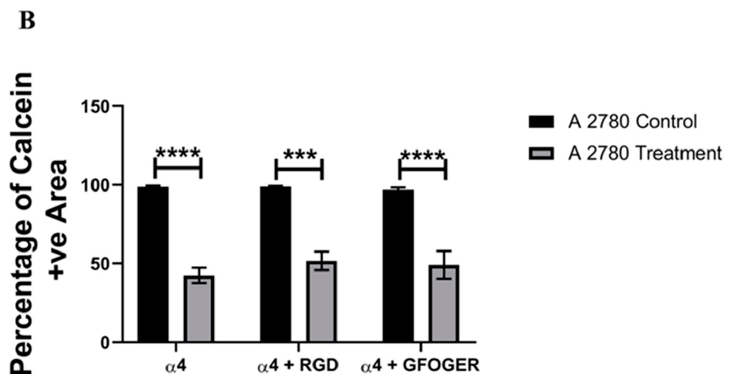
Figure 3. Effect of the chemotherapeutic Cisplatin on the viability of A2780 EOC cells grown in different synthetic PeptiGels, 24 h post-treatment ( A ): Representative images for live–dead (green– red) staining for both treated and untreated (control) A2780 PeptiGels. ( B ) Image analysis-based quantification of live (green) image areas for A2780 cells grown in the peptides. Scale bar = 200 μ m. Quantitative data represent mean ± SEM for multiple images ( ≥ 3) and multiple hydrogels ( ≥ 3). *** p ≤ 0.001, **** p ≤ 0.0001.